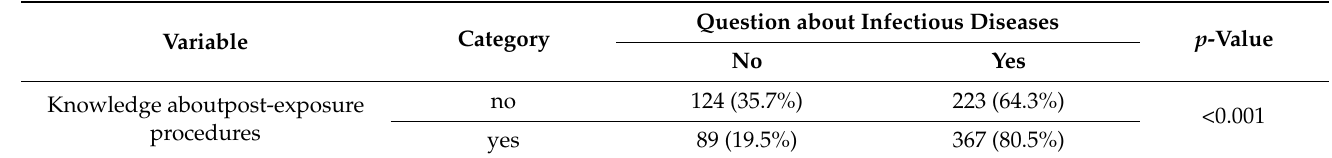
Table 4. Awareness and the risk of infections among beauticians followingparticipation in training on post-exposure procedures and from clients’ information about current/past infectious diseases (for example, viral diseases).